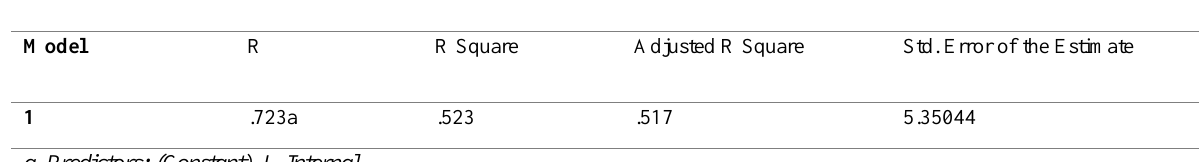
Table 1: Coefficient of Determination (R2) Model structure I Model Summary